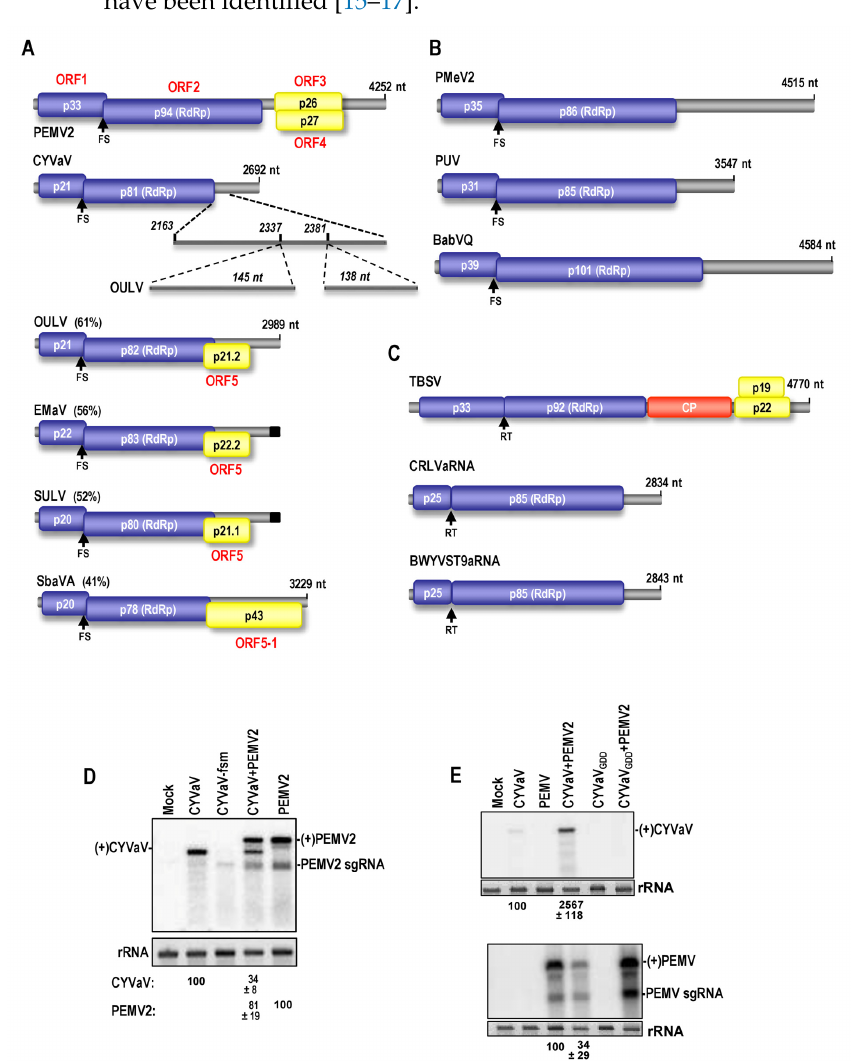
Figure 1. Gene organization of ulaRNAs and related viruses. ( A ) Genomes of the smaller ulaRNAs and umbravirus PEMV2. ORF1 and the -1PRF product (the RdRp) are found in all umbraviruses and ulaRNAs. The umbravirus ORF3 product is the long-distance movement protein and suppressor of NMD whereas the ORF4 product is required for cell-to-cell movement. ORF5, found in OULV, EMaV and SULV, and ORF5-1, found only in SbaVA, code for proteins with movement protein motifs (see Figure S1) and are possibly translated from an sgRNA (see Figure 9). CYVaV differs from OULV, EMaV and SULV by the absence of two fragments, which for OULV are 145 and 138 nt. The current length of SULV and EMaV are unknown, due to issues at the 5 (cid:48) and 3 (cid:48) ends (see text), which is represented by black boxes at the 3 (cid:48) end of their genomes. Percentages shown denote sequence identify with CYVaV. FS, -1PRF site. ( B ) Papaya and babaco ulaRNAs. ( C ) Genome organization of tomato bushy stunt virus (TBSV; tombusvirus) and two tlaRNAs, carrot red leaf virus associated RNA (CRLVaRNA) and beet western yellows virus ST9 strain (ST9aRNA). ( D ) Accumulation of CYVaV in protoplasts. A. thaliana protoplasts were inoculated with transcripts of CYVaV alone or coinoculated with transcripts of PEMV2 gRNA and total RNA was extracted 40 h later and examined by Northern blots. Blots were probed with combined oligonucleotide probes for both (+)CYVaV and (+)PEMV2. CYVaV, wild-type CYVaV; CYVaV-fsm, CYVaV with two nt alteration in the frameshift slippery site that suppresses translation of p81 (see Figure 8). Ethidium bromide-stained 28S rRNA was used as a loading control. Quantitation is from three independent experiments and standard deviation is shown. ( E ) Northern blot of RNA extracted from N. benthamiana leaves 7-days post-infiltration with CYVaV and/or PEMV2. Upper and lower panels were probed for (+)CYVaV and (+)PEMV2, respectfully. CYVaV GDD , CYVaV with a polymerase-inactivating mutation in the GDD active site. Experiments were repeated at least three times and average effect of the two gRNAs on each other (cid:48) s accumulation is shown along with standard